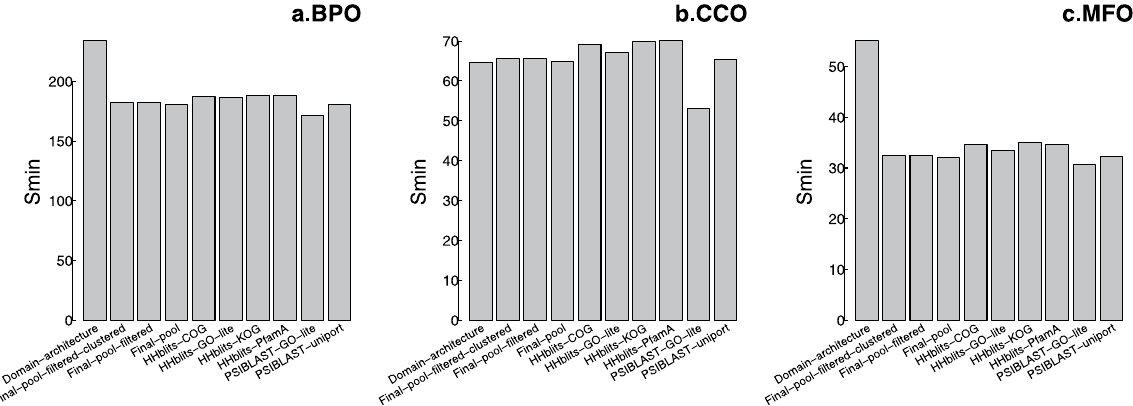
Figure 7. The S min scores for PANDA and other predictors. It can be found that PSI-BLAST-GO-lite has the lowest S min scores for CCO. Generally speaking, the other predictors including PANDA are having similar S min scores.